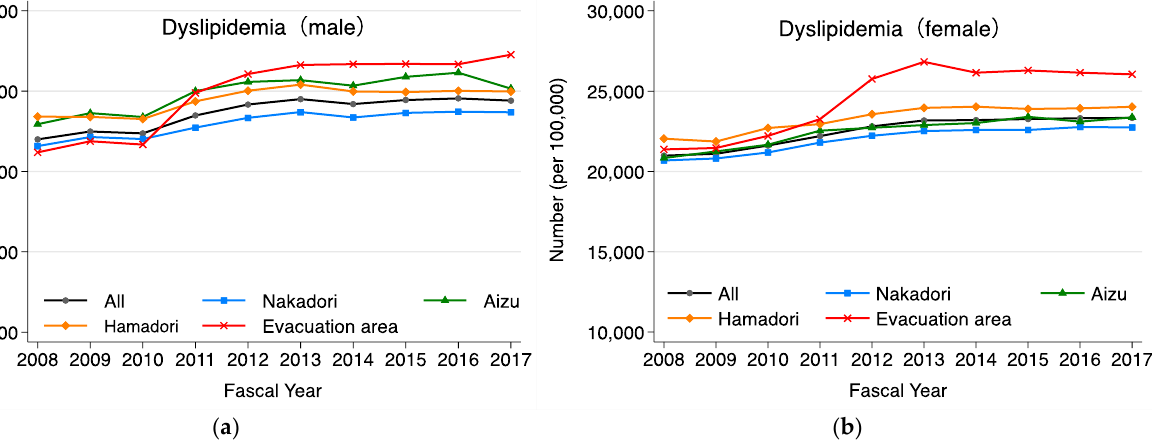
Figure 6. ( a ) Annual trend of age-adjusted dyslipidemia prevalence in males in each region. ( b ) Annual trend of age-adjusted dyslipidemia prevalence in females in each region. In addition to the four regions, trends for Fukushima Prefecture as a whole are also